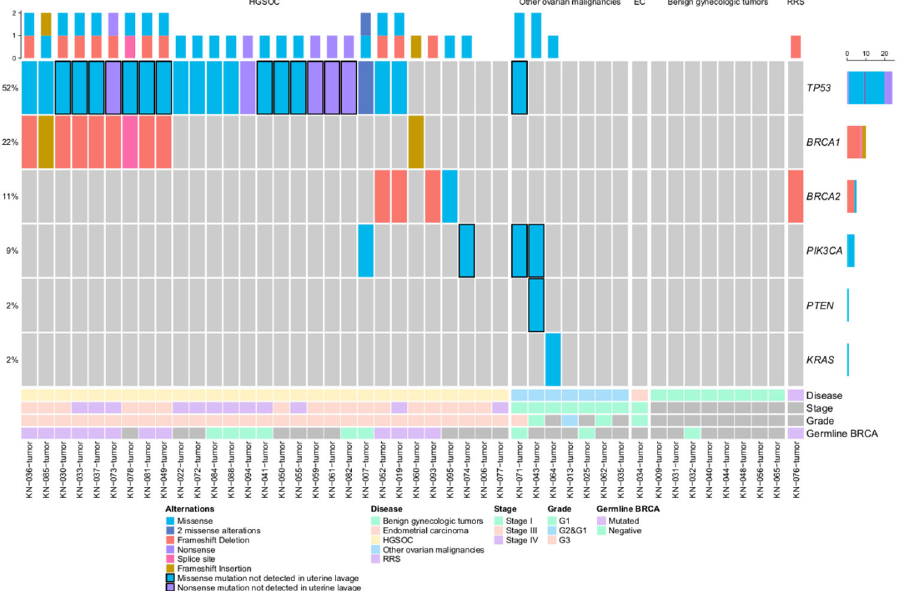
Figure 3. OncoPrint of ovarian tissue samples, EC—endometrial cancer. The black border indicates mutations not found in uterine lavage samples.